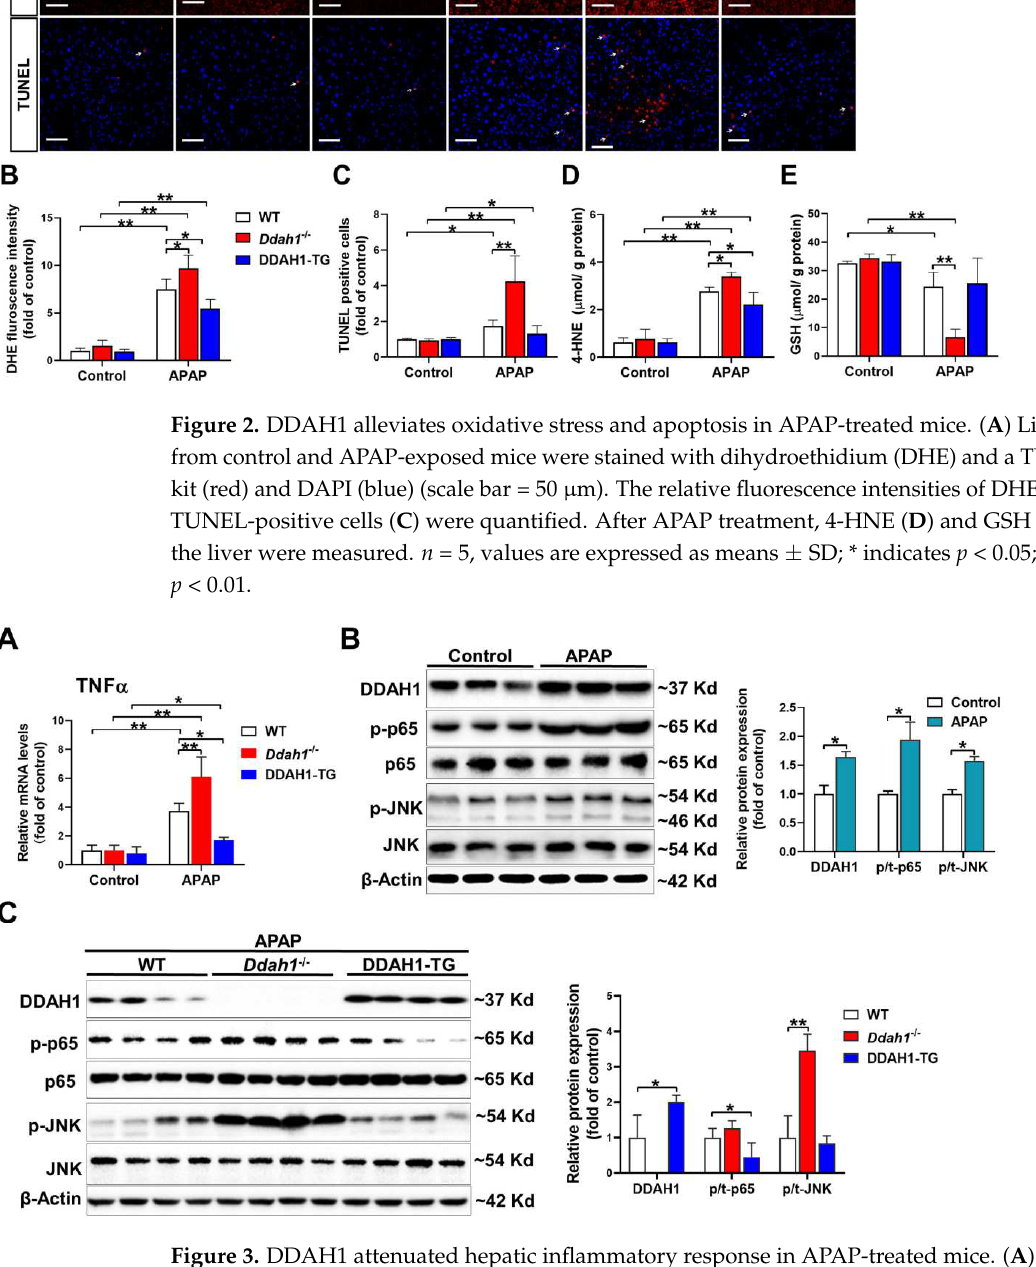
Figure 3. DDAH1 attenuated hepatic inflammatory response in APAP-treated mice. ( A ) The mRNA levels of TNFα were measured by real-time qPCR. ( B , C ) Liver lysates were examined by Western blot. n = 3–5, values are expressed as means ± SD; * indicates p < 0.05; ** indicates p < 0.01.